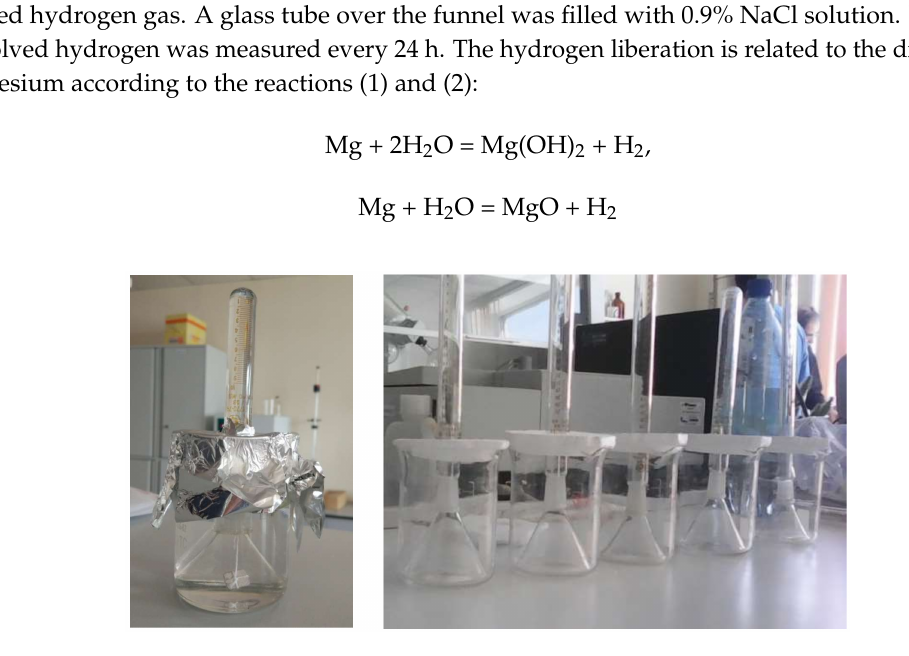
Figure 1. Photos of the system for evaluation of hydrogen